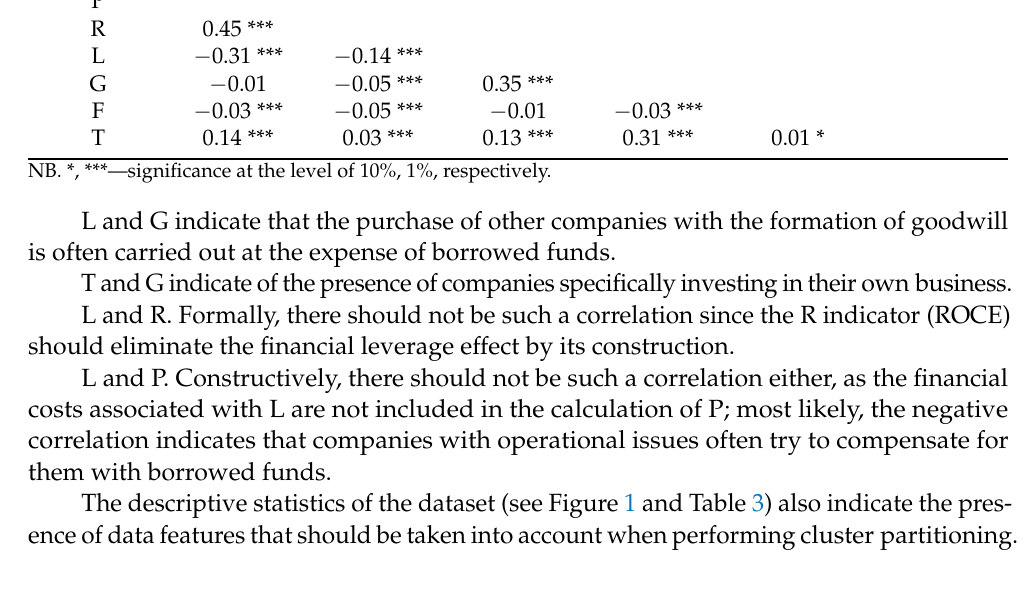
Table 2. Correlation matrix of indicators. P R